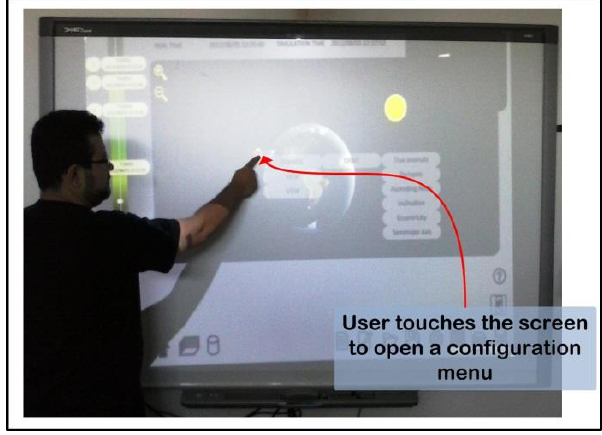
Fig. 21. Single-Touch interaction example for satellite orbital descriptions.